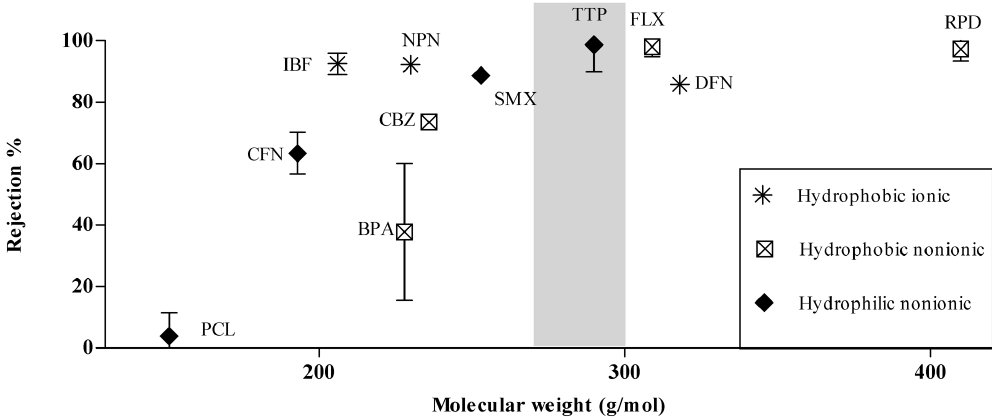
Figure 4. Rejection of trace organic compounds vs. their molecular weights. The high-lighted area indicates the MWCO of the NF270